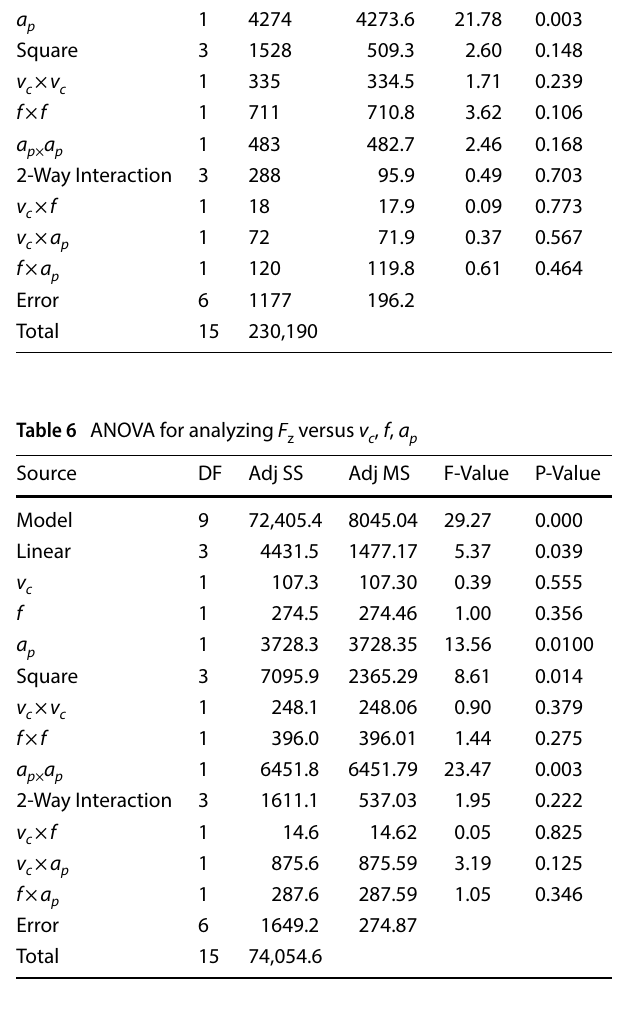
Fig. 9 Cutting force F z vs f , and v